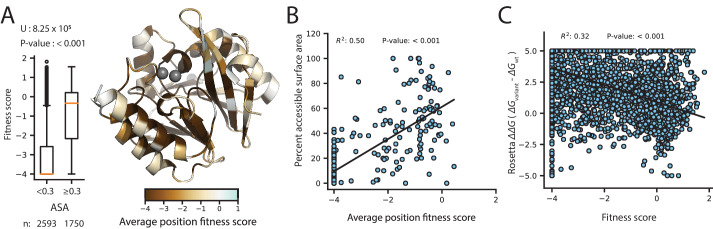
Correlation of fitness with structural attributes.Fitness scores are from DMS at 128 µg/mL AMP selection. (A) To the right, is the crystal structure of wtVIM-2 (PDB: 4bz3) colored by the average fitness of 20 amino acid mutations at each position. The inset to the left shows distributions of fitness scores for variants at positions with relative accessible surface area (ASA) <0.3 in wtVIM-2 or positions with ASA ≥0.3, with the number of variants in each distribution shown at the bottom and the results of a two-tailed Mann-Whitney U test between the two distributions at the top. (B) The correlation between accessible surface area and the average fitness of 20 amino acid mutations at each position. (C) The correlation between the changes in folding energy predicted by Rosetta and the DMS fitness scores for all variants.